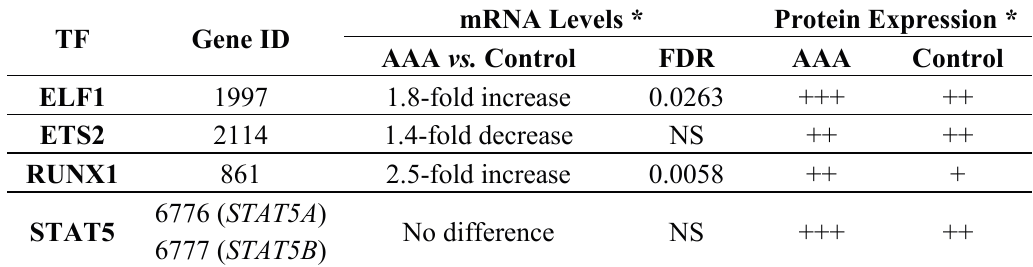
Table 1. mRNA and protein expression of transcription factors ELF1, ETS2, RUNX1 and STAT5 in human aneurysmal and non-aneurysmal infrarenal aorta.